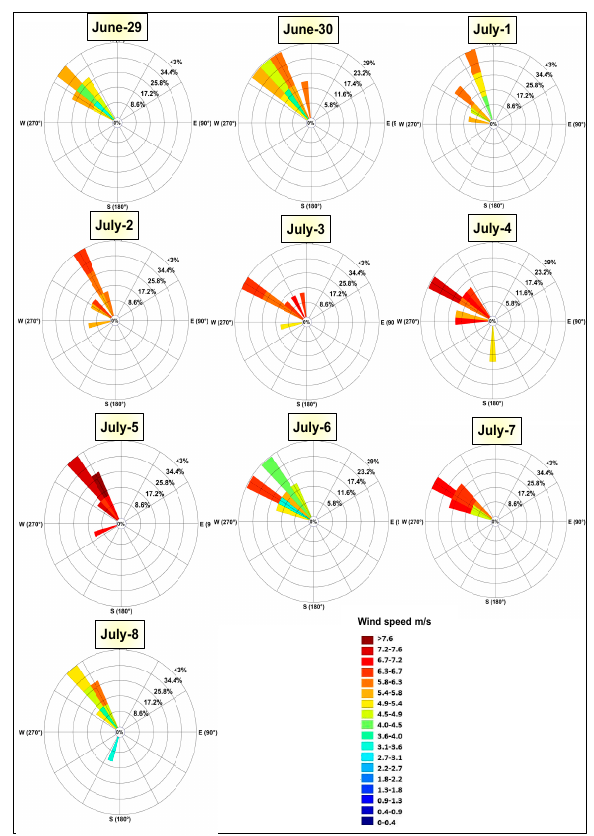
Figure 5. Wind rose plot for the measurement sites for 10 days (June 29 – July 8, 2009).